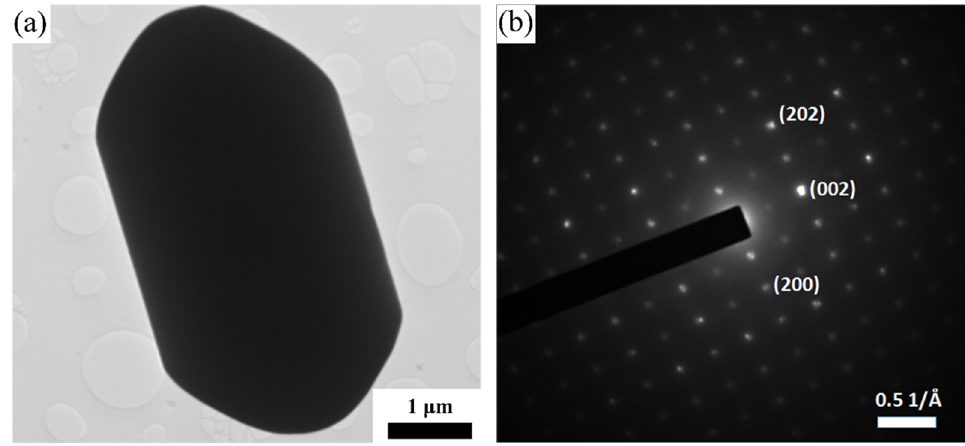
Figure 7. ( a ) TEM image and ( b ) selected area electron diffraction (SAED) of a representative MoAlB crystal in the sample, whose microstructure is shown in Figure 6.